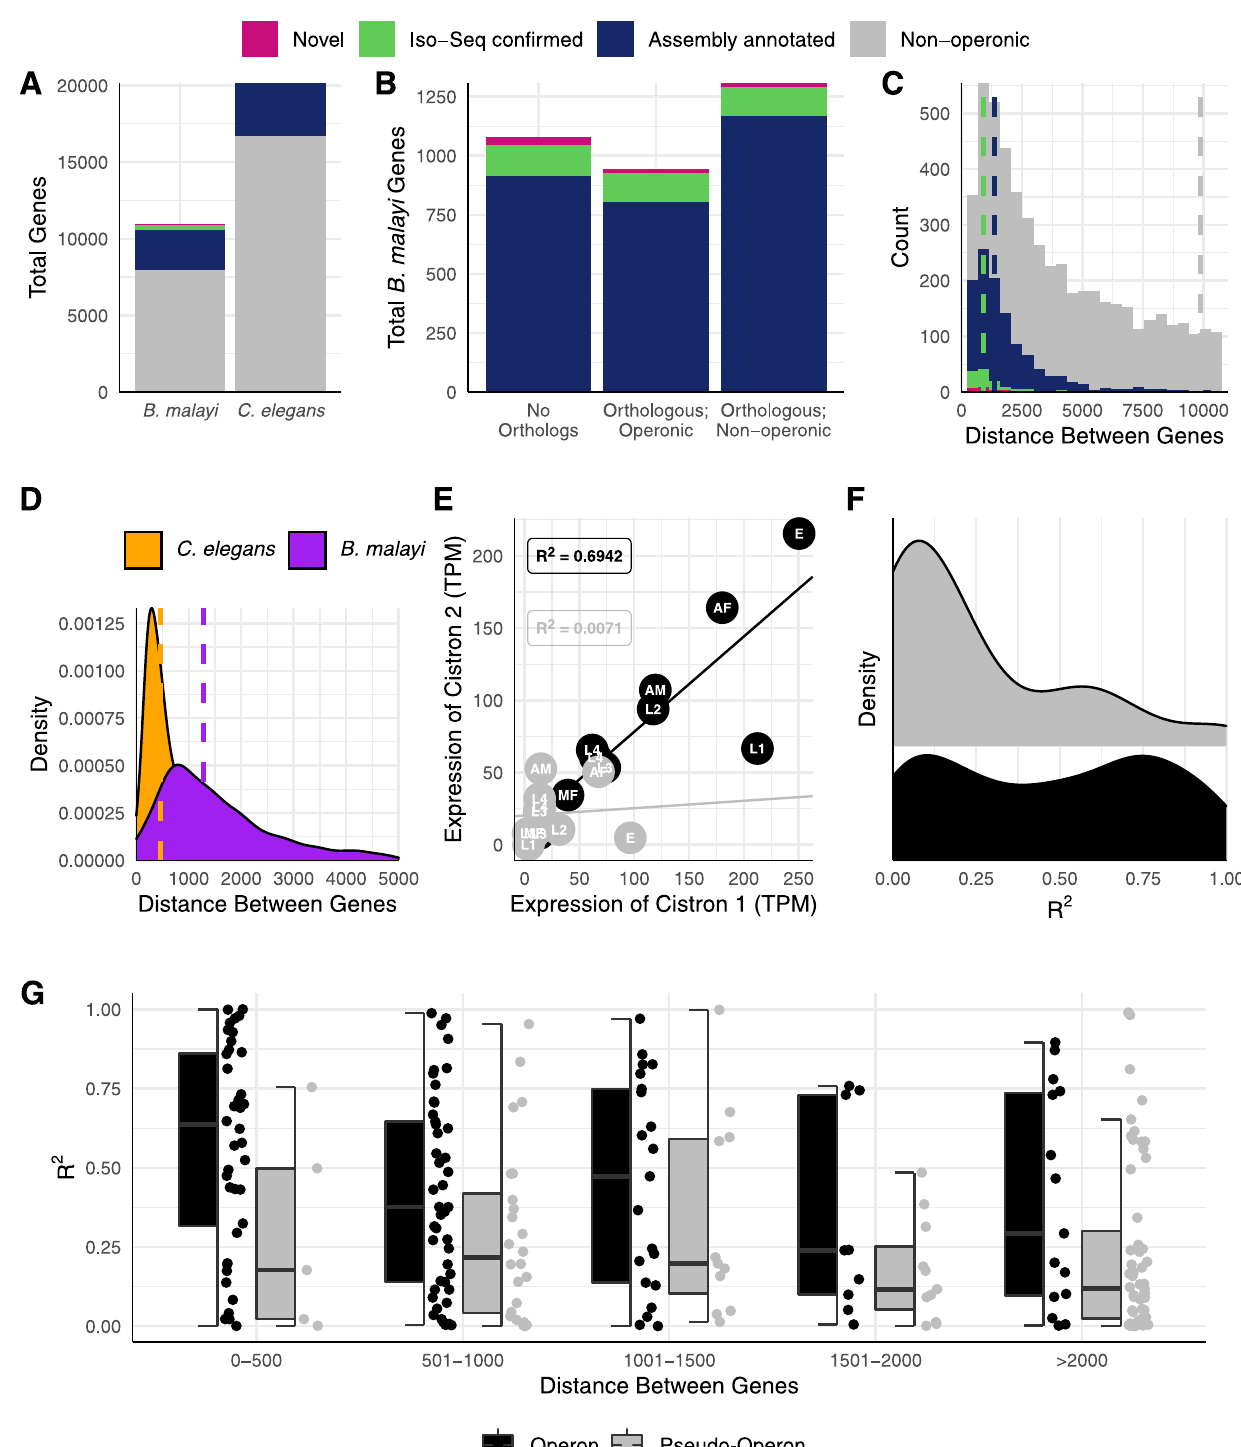
Fig 5. Identification and validation of over a hundred operons in B . malayi . (A) Iso-Seq identified new operons and validated assembly-annotated operons in B . malayi , which has a similar proportion of its genome arranged in operons as C . elegans . (B) Most B . malayi genes in operons have orthologs in C . elegans that are not in operons (39%), while 32% do not have orthologs, and 28% have orthologs that are also in operons. (C) Intercistronic distances between genes in operons are much shorter than intergenic distances between non-operonic genes (note that green and magenta median lines overlap). Operons identified via Iso-Seq (a median of 915.0 nucleotides for new operons, 906.5 for validated operons) on average had shorter intercistronic distances than those already annotated in the Bmal-4.0 assembly (1362.0). (D) B . malayi operons on average have larger (median = 1289 contrasted to 467 for C .